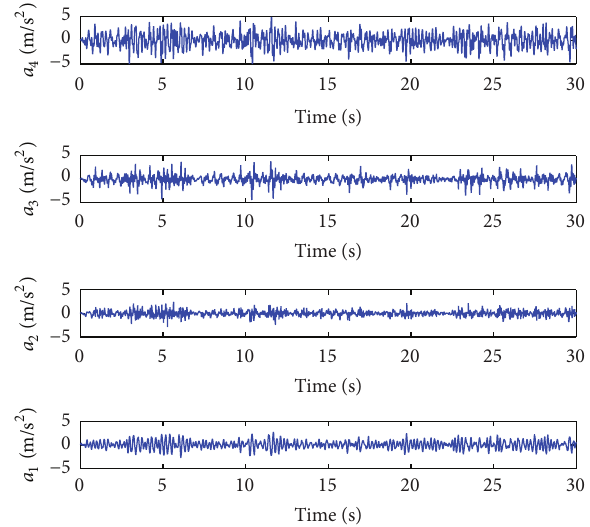
Figure 5: Measured acceleration responses for Case